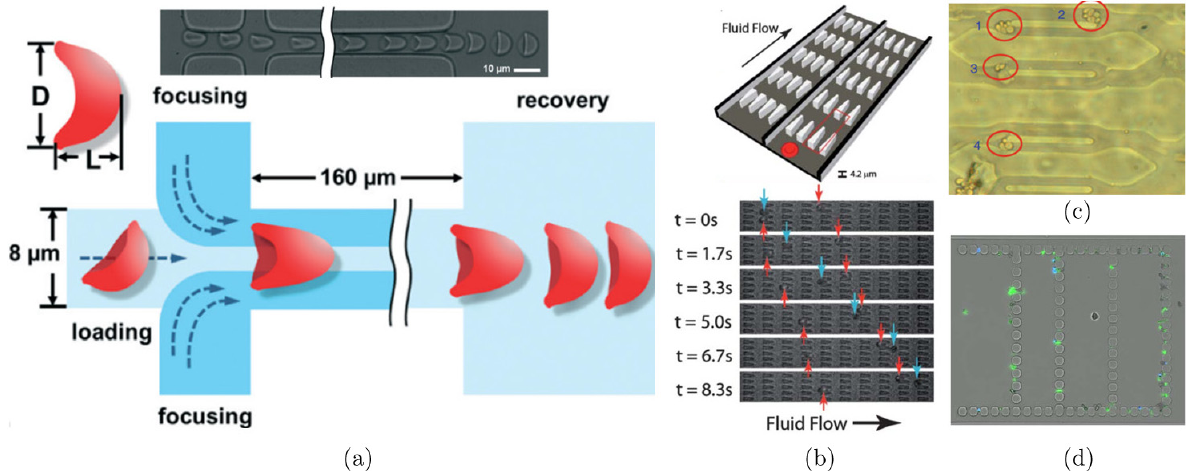
Fig. 4. The erythrocyte deformability studied by micro°uidic channels. (a) Schematic of a micro°uidic device for studying erythrocyte deformability by deformation index. (b) The microchannel with repeated taper constriction characterizes the eryth- rocyte deformability based on transit velocity detection. (c) The multi-channel micro°uidic network simulates the blockage of the microcirculation inside capillaries. (d) The biomimetic micro°uidic chip simulates the human spleen slits that capture poorly deformable erythrocytes. (a) is adapted with permission from Ref. 51, (b) is adapted with permission from Ref. 54, (c) is adapted with permission from Ref. 60 and (d) is adapted with permission from Ref.